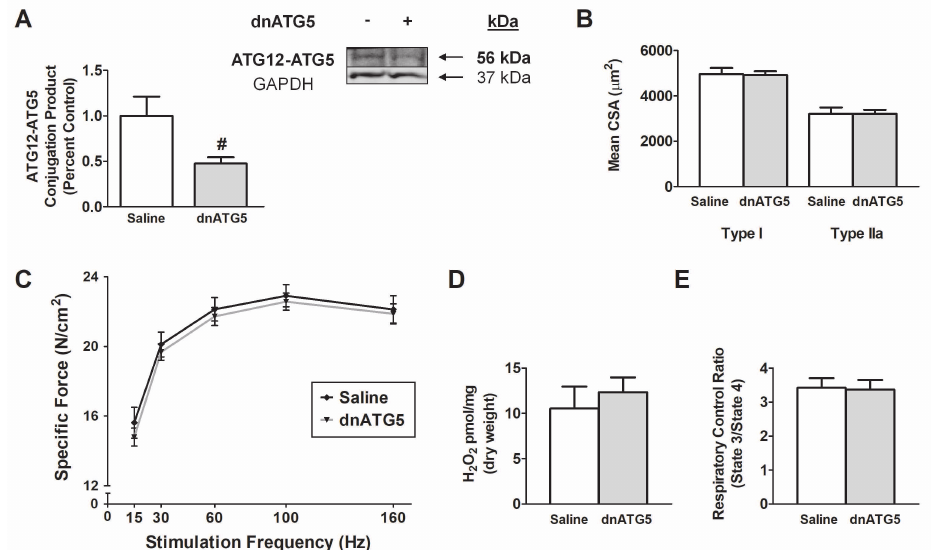
Figure 1. E ff ect of dominant negative ATG5 recombinant adeno-associated virus (rAAV-dnATG5) administration on: ( A ) ATG12-ATG5 conjugation, ( B ) soleus muscle fiber cross-sectional area (CSA), ( C ) soleus muscle-specific force production, ( D ) mitochondrial hydrogen peroxide (H 2 O 2 ) emission, and ( E ) mitochondrial respiratory control ratio (RCR). Values are represented as means ± SEM. # significantly di ff erent versus Saline ( p < 0.05).